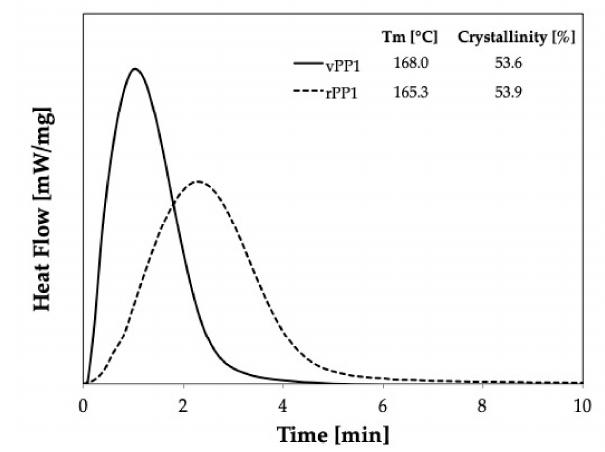
Figure 8. Crystallization curves obtained at 139 °C for virgin material (vPP1), and recycled material (rPP1). (rPP1).